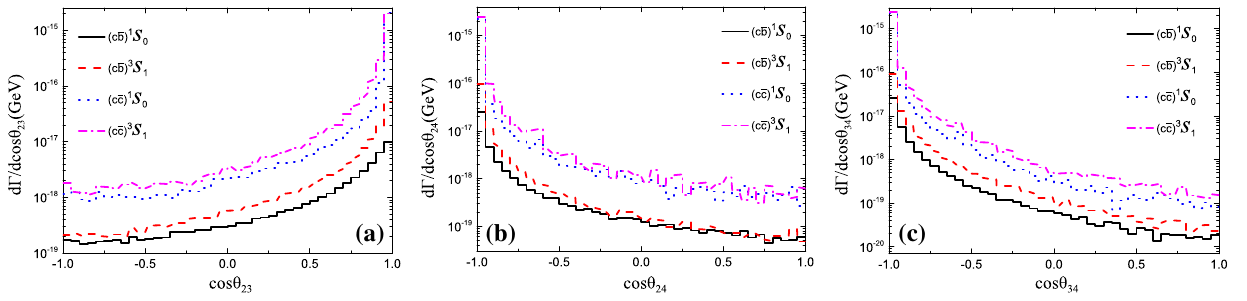
Fig. 3 The differential decay widths d (cid:2)/ d cos θ 23 ( a ), d (cid:2)/ d cos θ 24 ( b ) and d (cid:2)/ d cos θ 34 ( c ) for t → | ( c ¯ Q ) [ n ](cid:5) + Q + Z 0